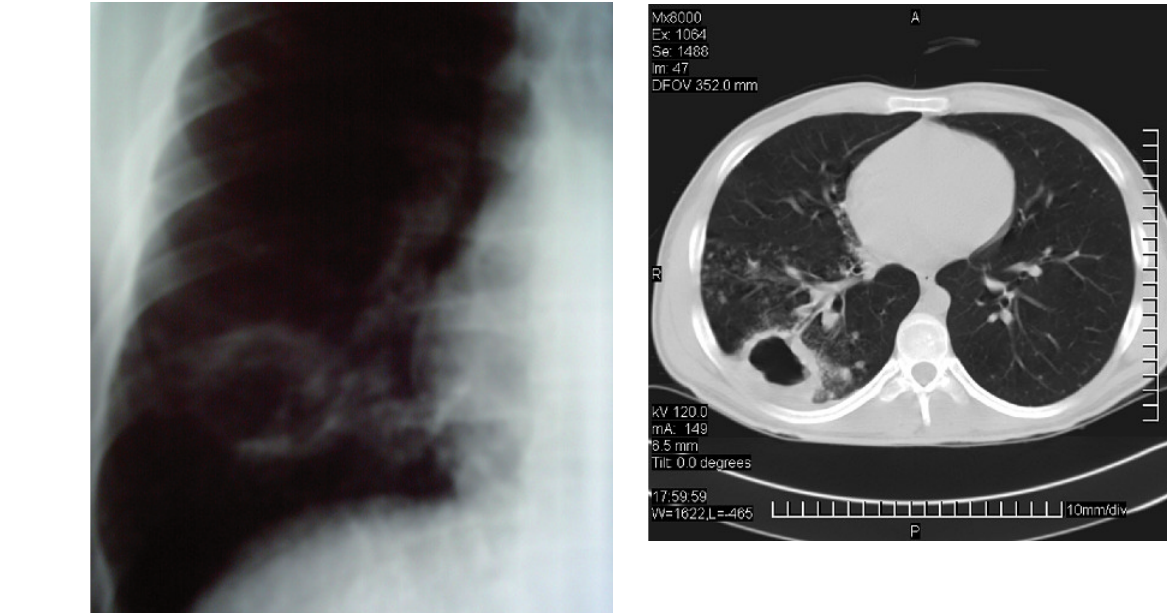
CT scan revealing the cavernous lesion with connection to the bronchial tree and military seeding to the left